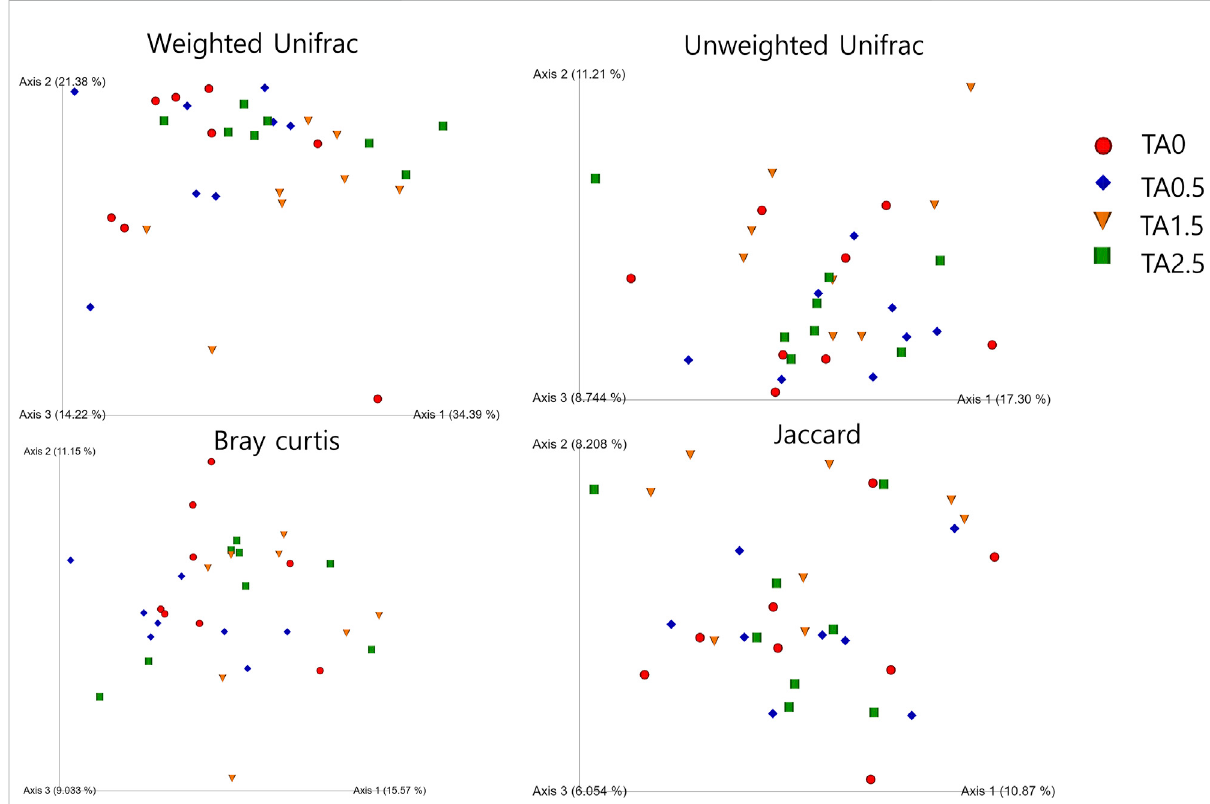
FIGURE 12 Visualizationof beta diversity indices (weighted and unweighted Unifrac, bray curtis, and jaccard) in the broilers of thetannic acid 0 (TA0): basal diet without tannic acid; 2) tannic acid 0.5 (TA0.5):basal diet with 0.5 g/kg tannic acid; 3) tannic acid 1.5 (TA1.5); and 4) tannic acid 2.5 (TA2.5) groups on D 21. The treatment groups were compared using one-way ANOVA followed by the Tukey ’ s multiple comparison. Different superscripts differ at p <